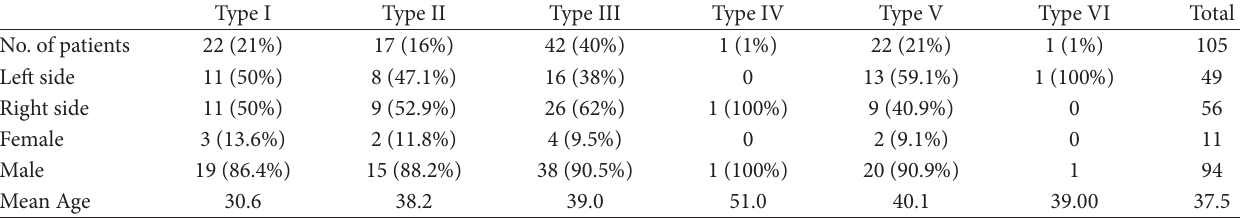
T 2: Demographical data and distribution of AC dislocation among the study